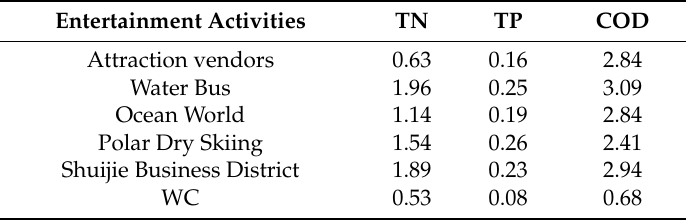
Table 1. Main areas of the playground pollutant concentration (mg/L).